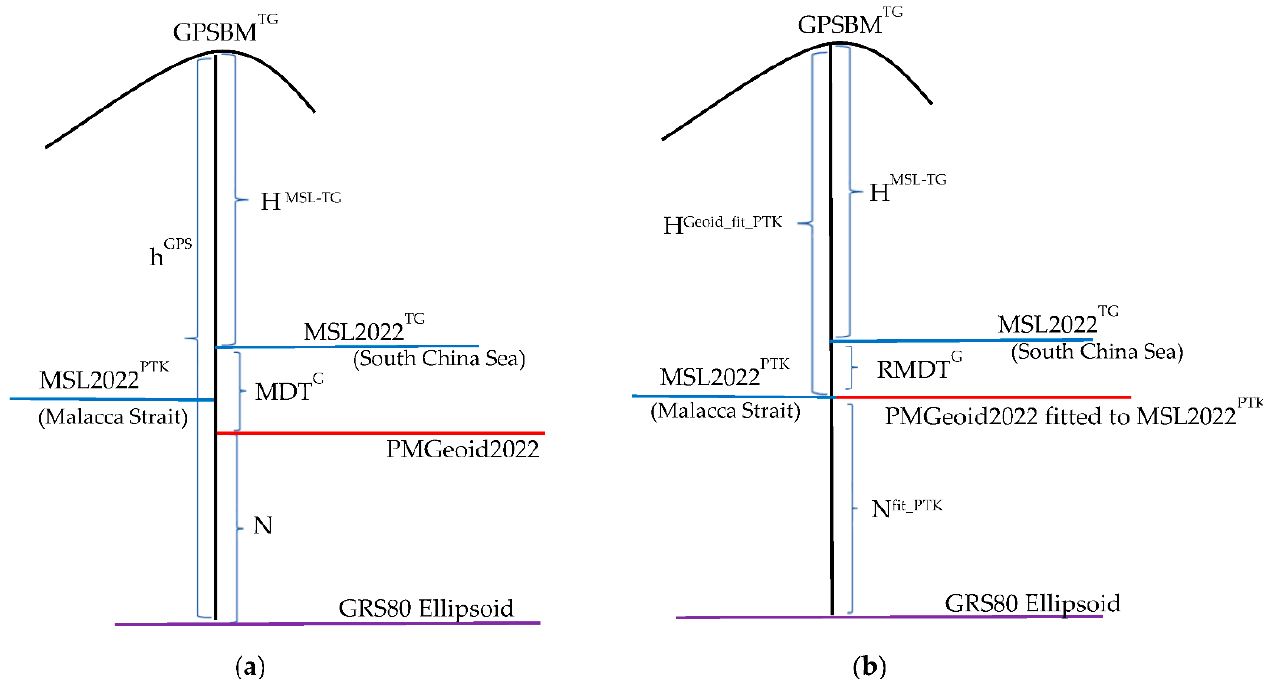
been fitted to the relative MSL2022B at PTK, the MDT G at TG-GPSBM PTK is equal to zero. Therefore, the differences in orthometric heights at a TG-GPSBM with respect to the fitted PMGeoid2022 at Port Klang TG (TG PTK ) and to the local MSL TG provide the relative-MDT G (RMDT G ) or sea slope between TG PTK and TG i : RMDT PTK-TG = MDT TG −